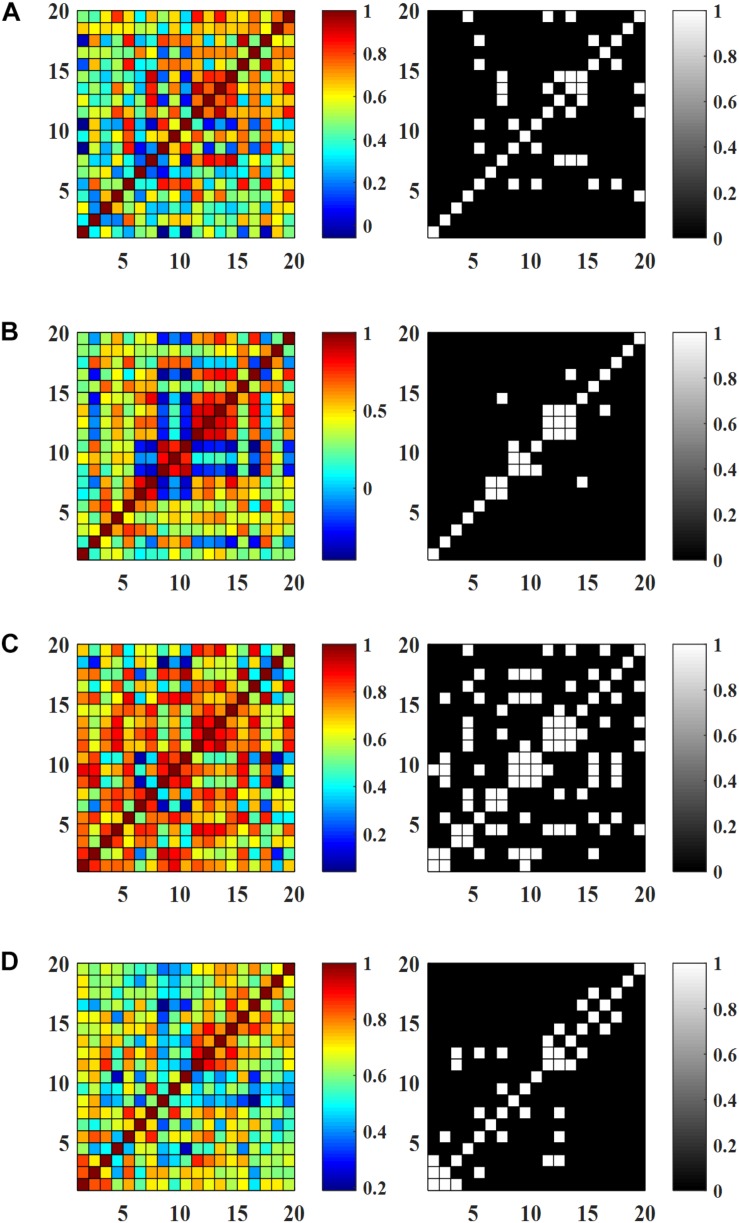
Resting state functional connectivity and the corresponding binary matrices (threshold value 0.8): (A) HC, (B) MCI-0, (C) MCI-1, and (D) MCI-2.